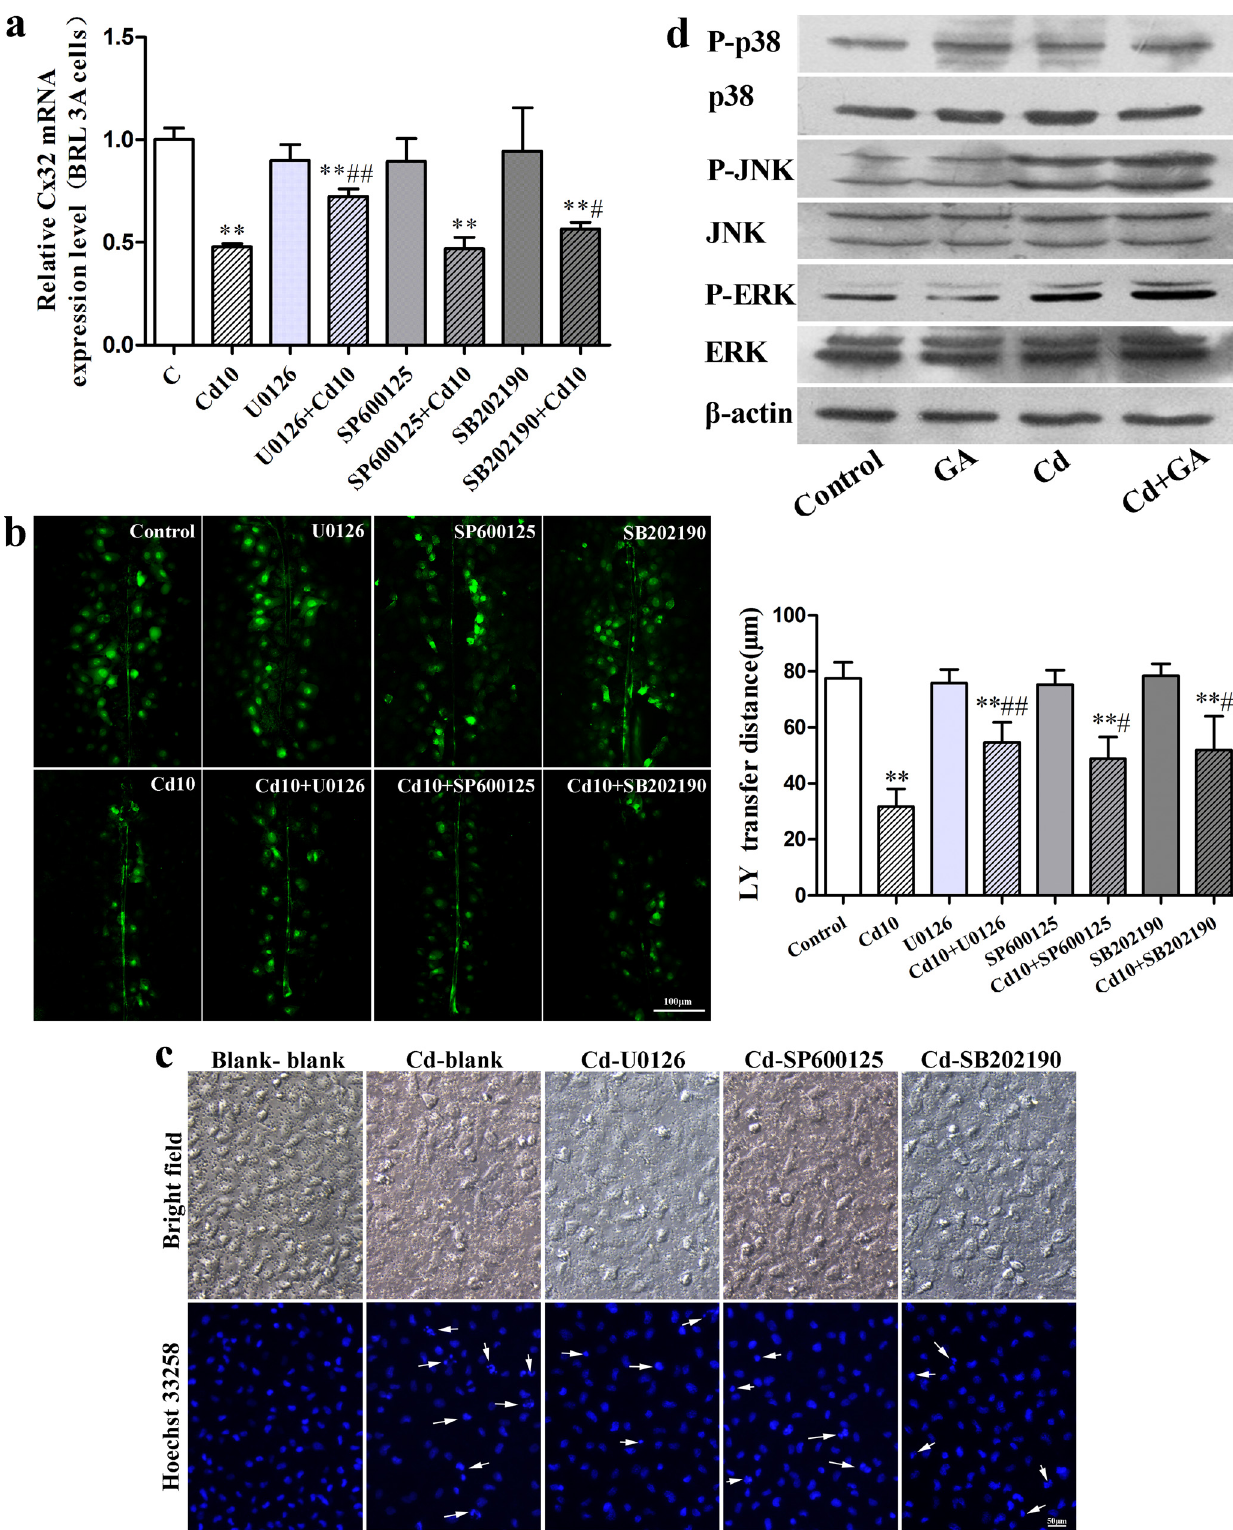
Fig 5. The interaction between GJIC and the MAPK pathway plays an important role in Cd-induced cytotoxicity. a : Effect of U0126, SP600125 and SB202190 on Cx32 mRNA expression in BRL 3A cells; b : Effect of U0126, SP600125 and SB202190 on the Cd-induced down-regulation of GJIC in BRL